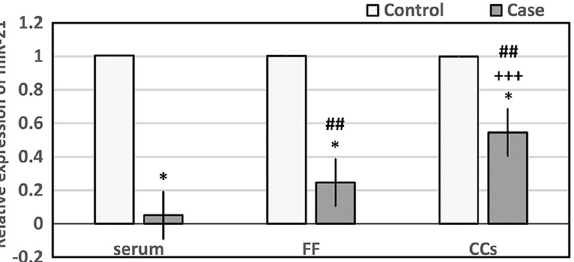
Figure 2. Comparison of miR-21 expression between the case and control groups. The level of miR-21 expression was significantly lower in the serum, FF, and CCs samples in the case group compared to the control group based on the t-test, * p < 0.05. The comparison of expression of miR-21 among three media (serum, FF, and CCs samples) in pairs indicated that the level of miR-21 expression was significantly higher in the FF and CCs than in the serum in the case group on the Anova test, ## p < 0.05. The miR-21 expression was significantly increased in the CCs than in the FF in the case group on the Anova test, +++ p < 0.05. The results are presented as the mean ± SEM. FF : Follicular Fluid, CCs : Cumulus Cells.